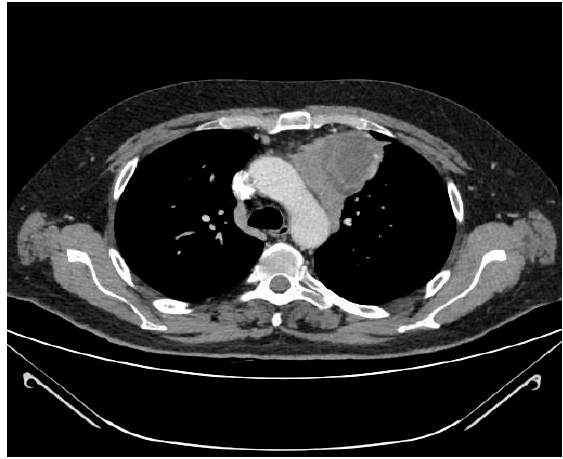
Figure 2. Mediastinal fat invasion. A higher incidence of regular contours ( p = 0.034) and a lower incidence of lung ( p = 0.009) invasion were observed in patients with stage I tumors according to the TNM staging system (Figure 3). Stage I tumors according to M-K had a higher incidence of oval shape ( p = 0.003) and a lower incidence of mediastinal fat invasion ( p = 0.022), contact with mediastinal vessels ( p = 0.008) and pericardium ( p = 0.032) (Table